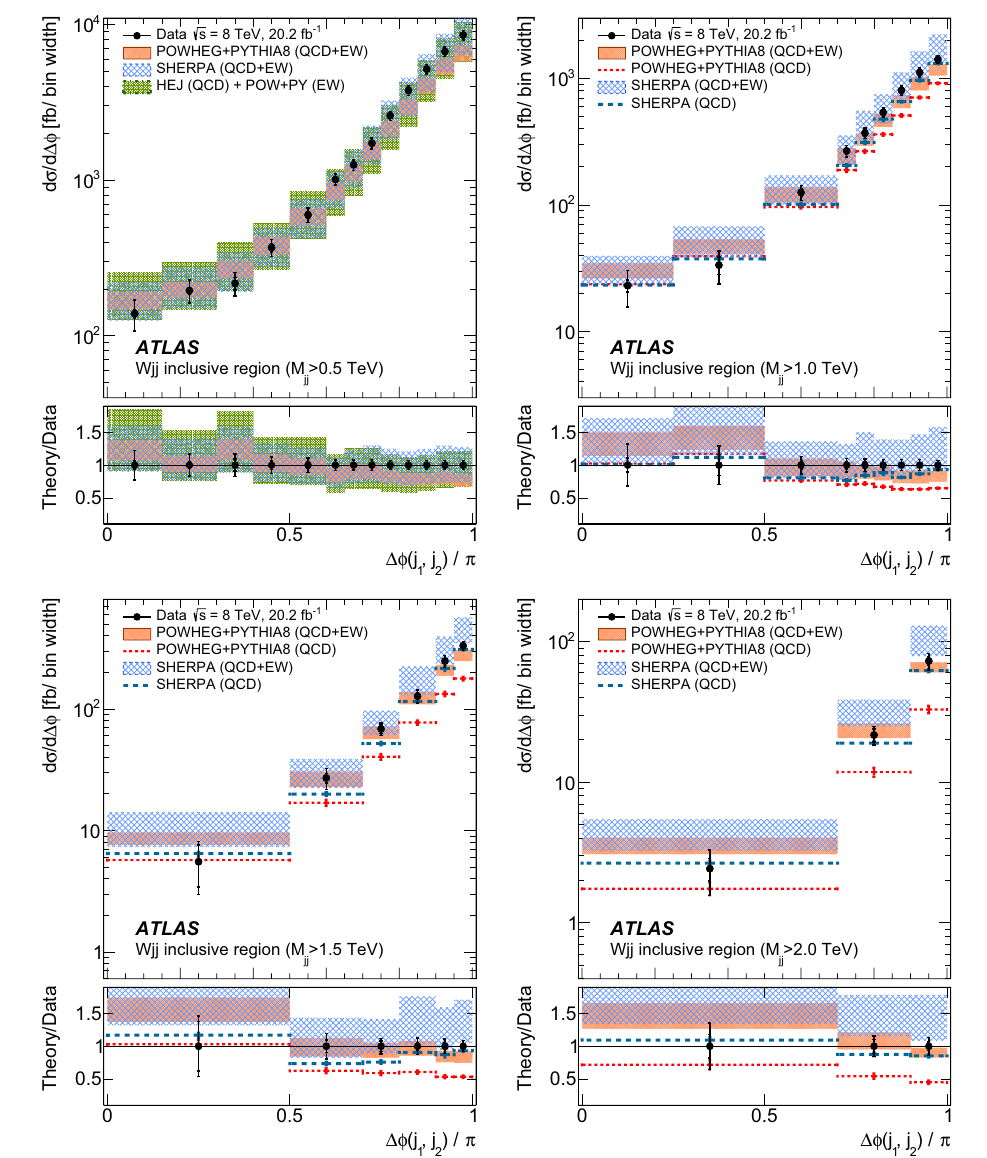
Fig. 51 Differential W jj production cross sections as a function of (cid:6)φ( j , j ) in the inclusive fiducial region with four thresholds on the 1 2 dijet invariant mass (0.5, 1.0, 1.5, and 2.0 TeV). Both statistical ( inner